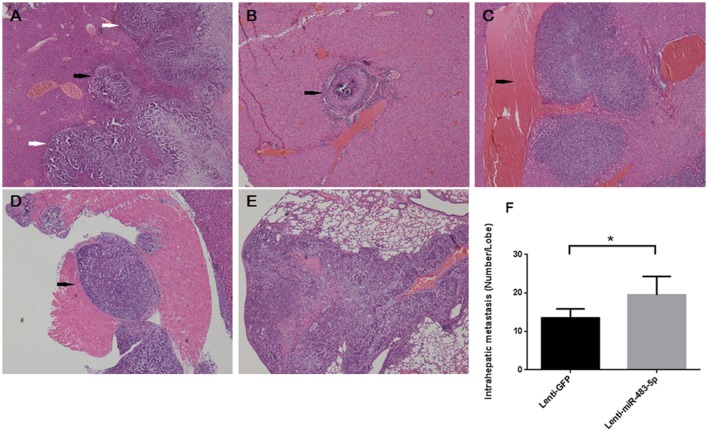
miR-483-5p promotes HCC cell invasion and metastasis in vivo, (A–F) showed intrahepatic metastasis and distant metastasis (lung) in Lenti-miR-483-5p mice. (A) Orthotopic primary liver tumor (white arrows) and intrahepatic metastatic nodules close beside tumor (black arrow). (B) Distant microvascular invasion in another liver lobe (black arrow). (C) Intrahepatic metastatic nodules close beside larger vein branch (black arrow). (D) Metastatic nodules invasion smooth muscular tissue near liver (black arrow). (E) Distant metastasis in the lung. (F) The numbers of metastatic nodules in the livers of each mouse are counted; the statistical significance is labeled using the 2 test. *p < 0.05, HE stained ×40.